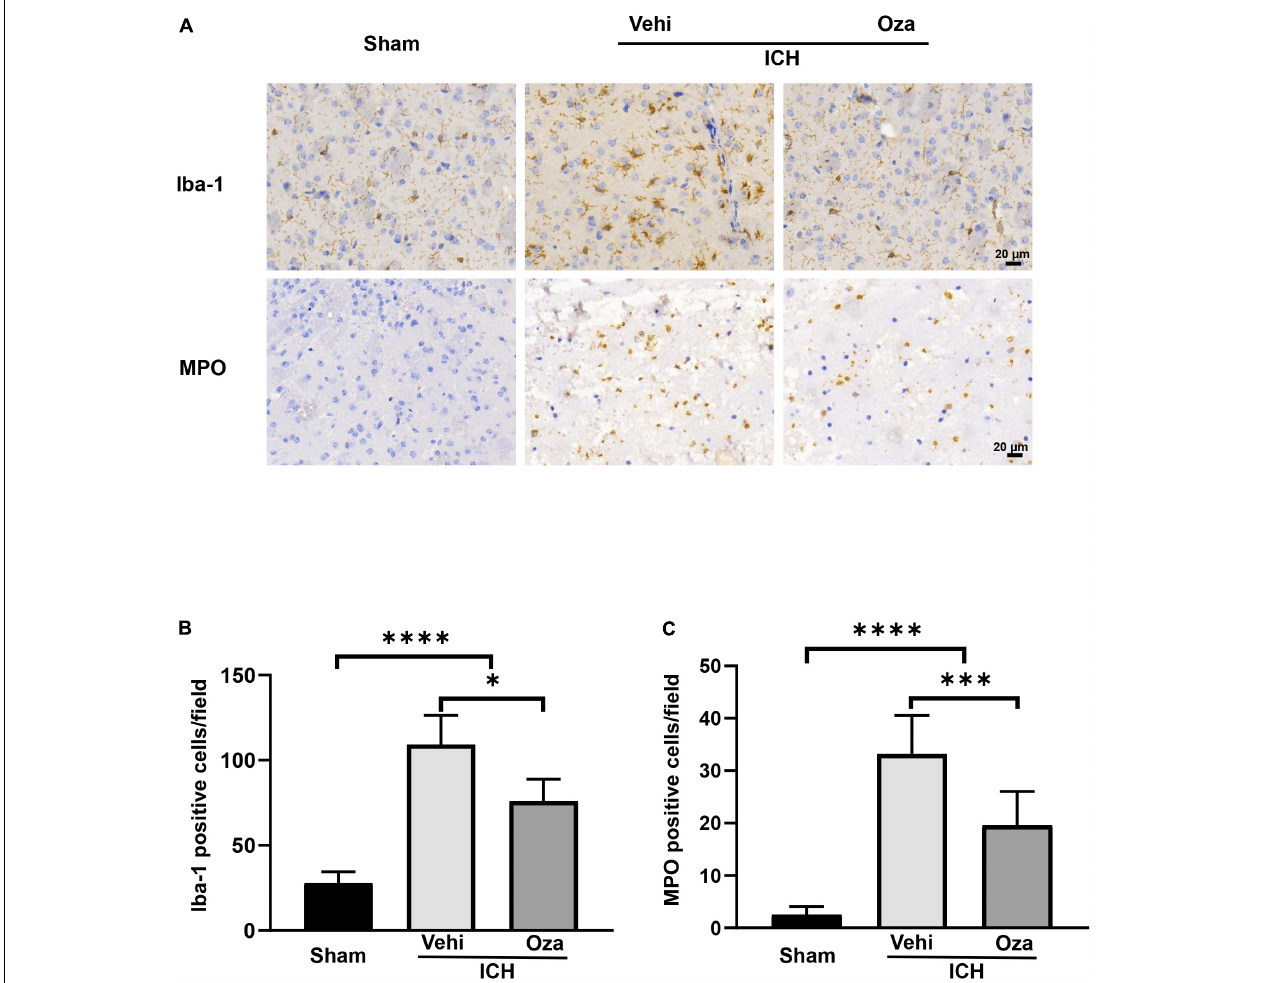
FIGURE 3 | The effects of Ozanimod on microglia/macrophages density and neutrophil infiltration at 3 days after ICH. (A) Immunohistochemical results showed microglia (Iba-1) representation and neutrophil (MPO) infiltration around the hematoma. (B,C) A significant reduction in infiltration of neuroinflammatory cells was found in the Ozanimod compared to the vehicle group. Data are presented as mean ± SD ( n = 6, Bar = 20 µ m). ∗ p < 0.05, ∗∗∗ p < 0.001, ∗∗∗∗ p <